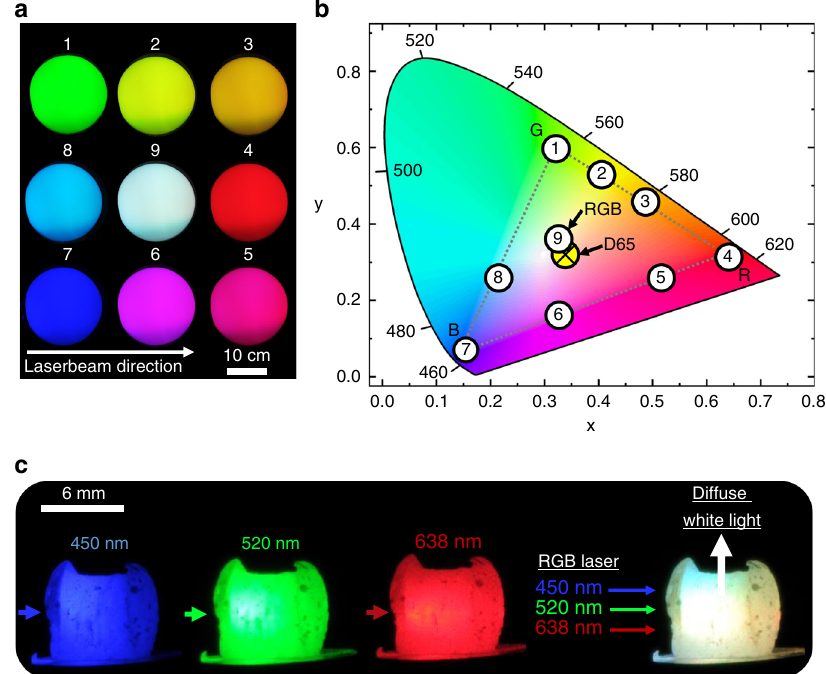
Fig. 6 Colour mixing. a Light distribution of a high ρ Aero-BN sample illuminated in the middle of a translucent glass bulb under different intensities for the each wavelength (450, 520, and 638 nm). White light is produced when all lasers (R + G + B) are at the maximum power (100 mW). b CIE colour map with marked values for the pictures in a . The value obtained for mixing R + G + B is close to the CIE standard white illuminant D65 62 (yellow circle). c Photographs of a sample with ρ Aero-BN ~0.68 mg cm − 3 illuminated at 450, 520, and 638 nm (100 mW each, 1 mm spot size), respectively, as well as the resultant white light produced if all lasers are used at once. The arrows mark the direction of the incident laser